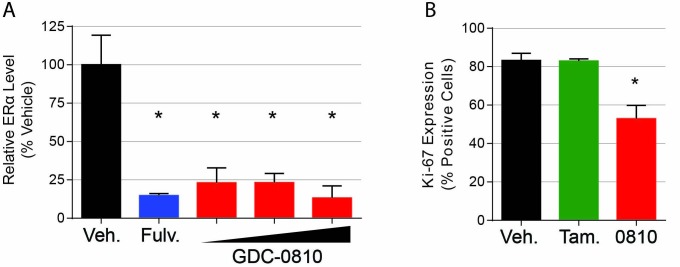
Pharmacodynamic activity of GDC-0810 in MCF7-TamR1 xenograft tumors.(A) ERα protein levels were determined by western blot analysis of tumors 8 hr following the final compound treatment on day 27. ERα levels were normalized to α-tubulin and normalized to the average of the Vehicle (+E2) group. Data is presented as average of treatment group [4 tumors each for Vehicle (+E2), Vehicle (-E2), and fulvestrant 200 mg/kg 3x/week and 3 for GDC-0810 10, 30 and 100 mg/kg/day]. Error is standard deviation. * Denotes significance (p<0.05) compared to Vehicle in 1-Way ANOVA and Dunnett's Multiple Comparison Test. (B). KI-67 expression, quantified from IHC analysis.